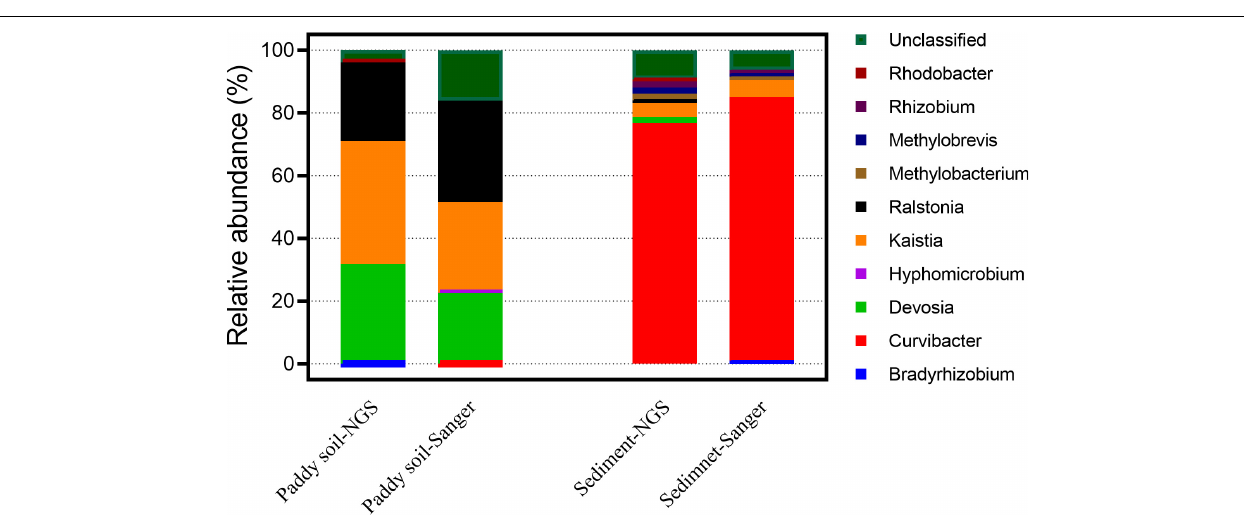
Frontiers in Microbiology |